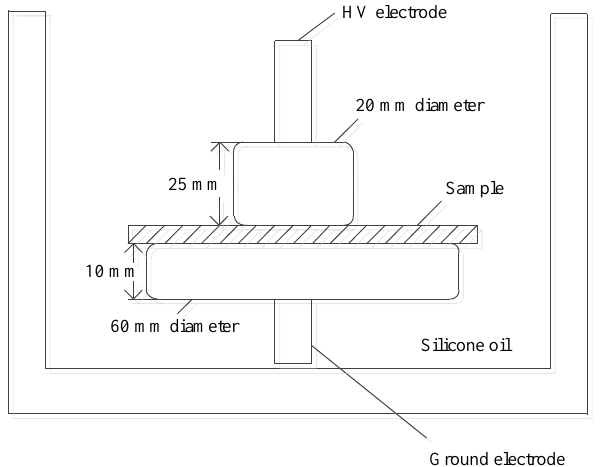
Figure 1. Schematic diagram of breakdown experimental device.